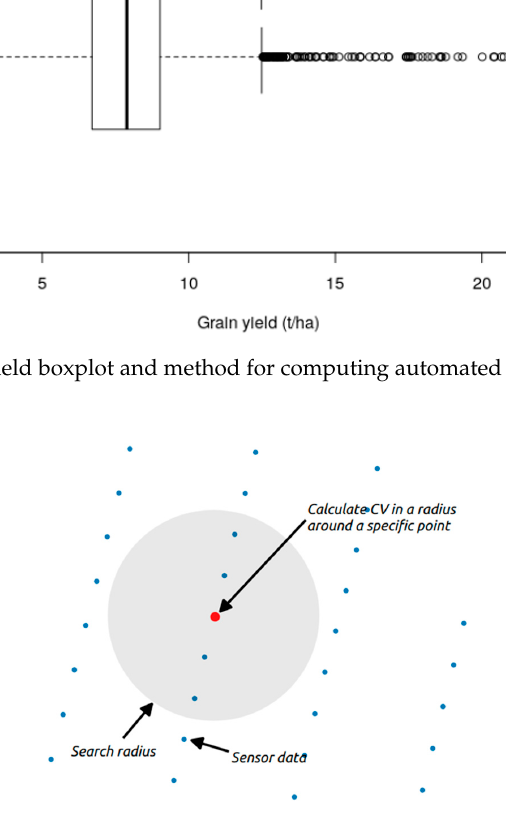
( b ) Figure 7. Variogram forms: ( a ) bounded variogram; ( b ) pure nugget (modified from [40]).